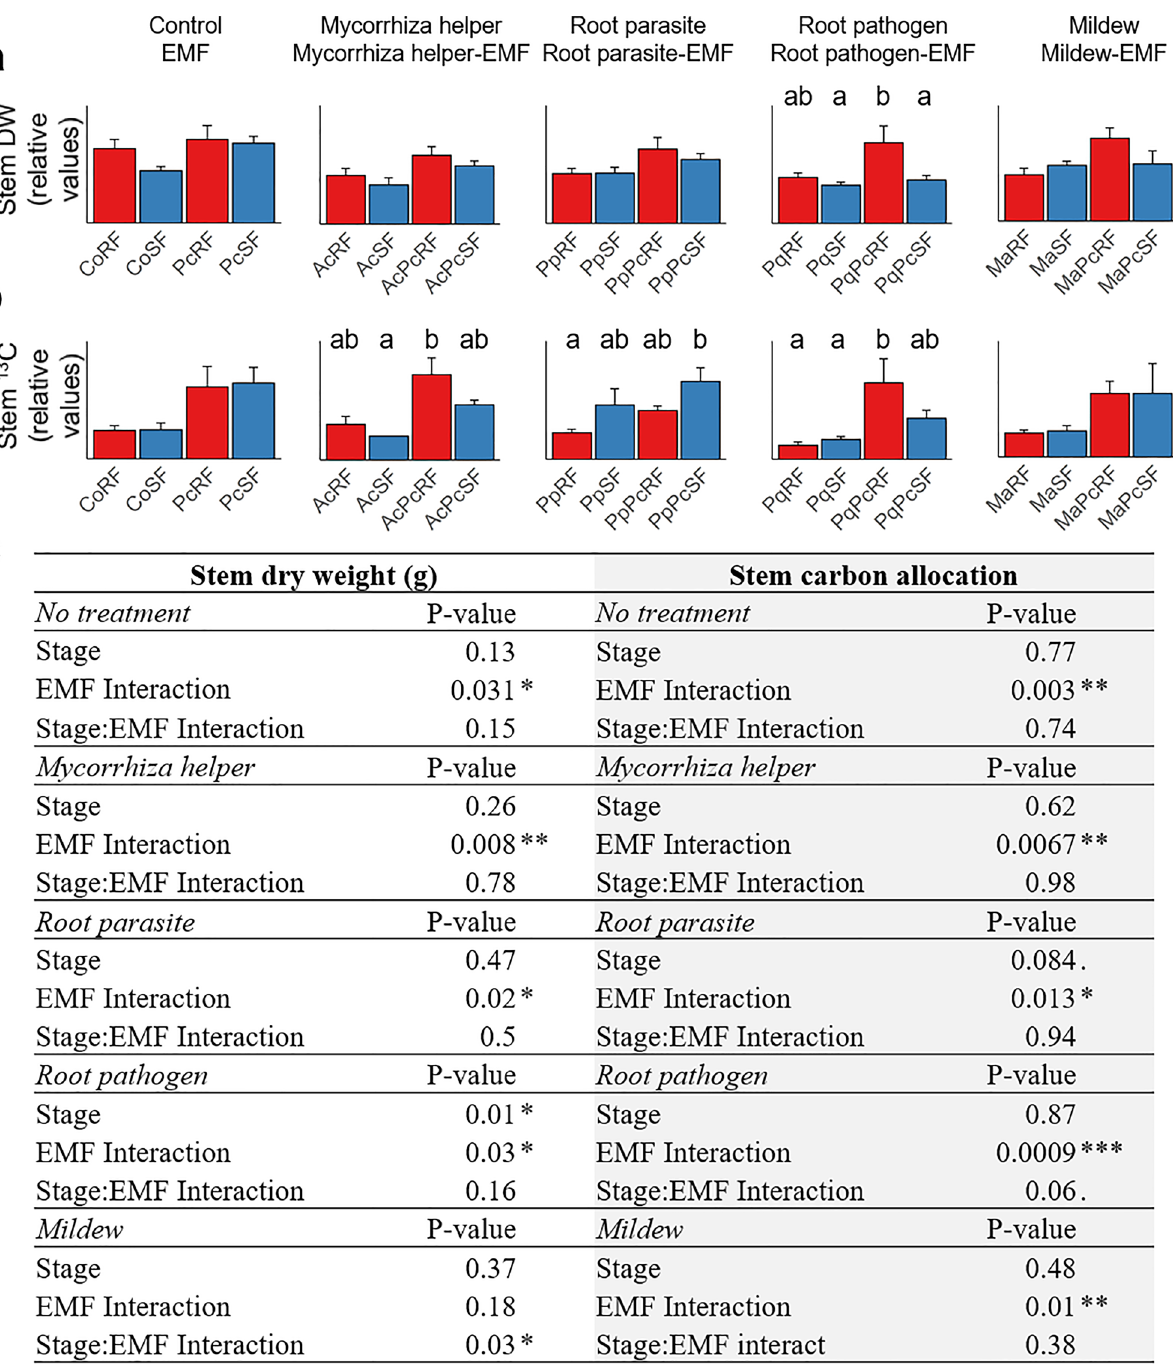
Figure 4. Effect of the ectomycorrhizal fungus on stem biomass and carbon allocation. ( a ) Stem biomass (g dry weight). ( b ) Carbon allocation to stem ( 13 C excess). Different letters indicate a significant difference according to linear model, ANOVA and Tukey’s test, at the significance level P < 0.05. For the purpose of simplicity, relative values are shown here, and absolute values are given in Supplementary Fig. S3. ( c ) Effect of the EMF on biomass partitioning to stems. Data were analysed by linear model and the relative effects and the interaction between growth stage (RF/SF) and EMF (no/yes) were assessed by using two-way ANOVA. DW, dry weight; 13 C, allocation of C-13; RF, root flush; SF, shoot flush; Pc, Piloderma croceum , Ac, Streptomyces sp. AcH505; Pp, Pratylenchus penetrans , Pq, Phytophthora quercina ; Ma, Microsphaera Collembola can also feed on EMF mycelium and inhibit EM formation 34 , but since the grazing may stimulate compensatory growth of the hyphae, mycelial biomass may not decrease but even increase due to moderate grazing 29,35 . Finally, some reports show that leaf herbivory inhibits EM formation 36,37 , but it may also speed up assimilate transport to roots 18,38 . In sum, this suggests that consumers cause changes in root growth and resource